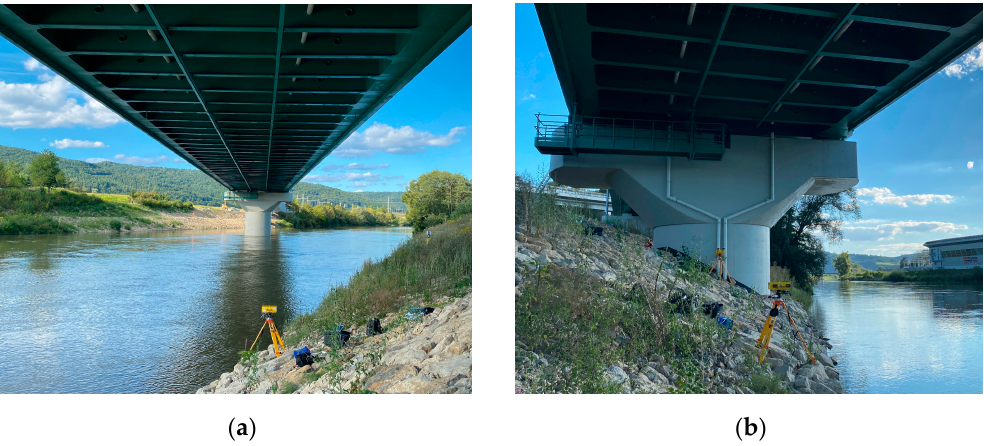
Figure 20. Used interferometric radars: ( a ) Bottom view on the bridge deck of the structure BS2 with the steel crossbeams from the position of the radar R1; ( b ) View on both radars: R1 is in the foreground, and R2 is in the background in the photo.